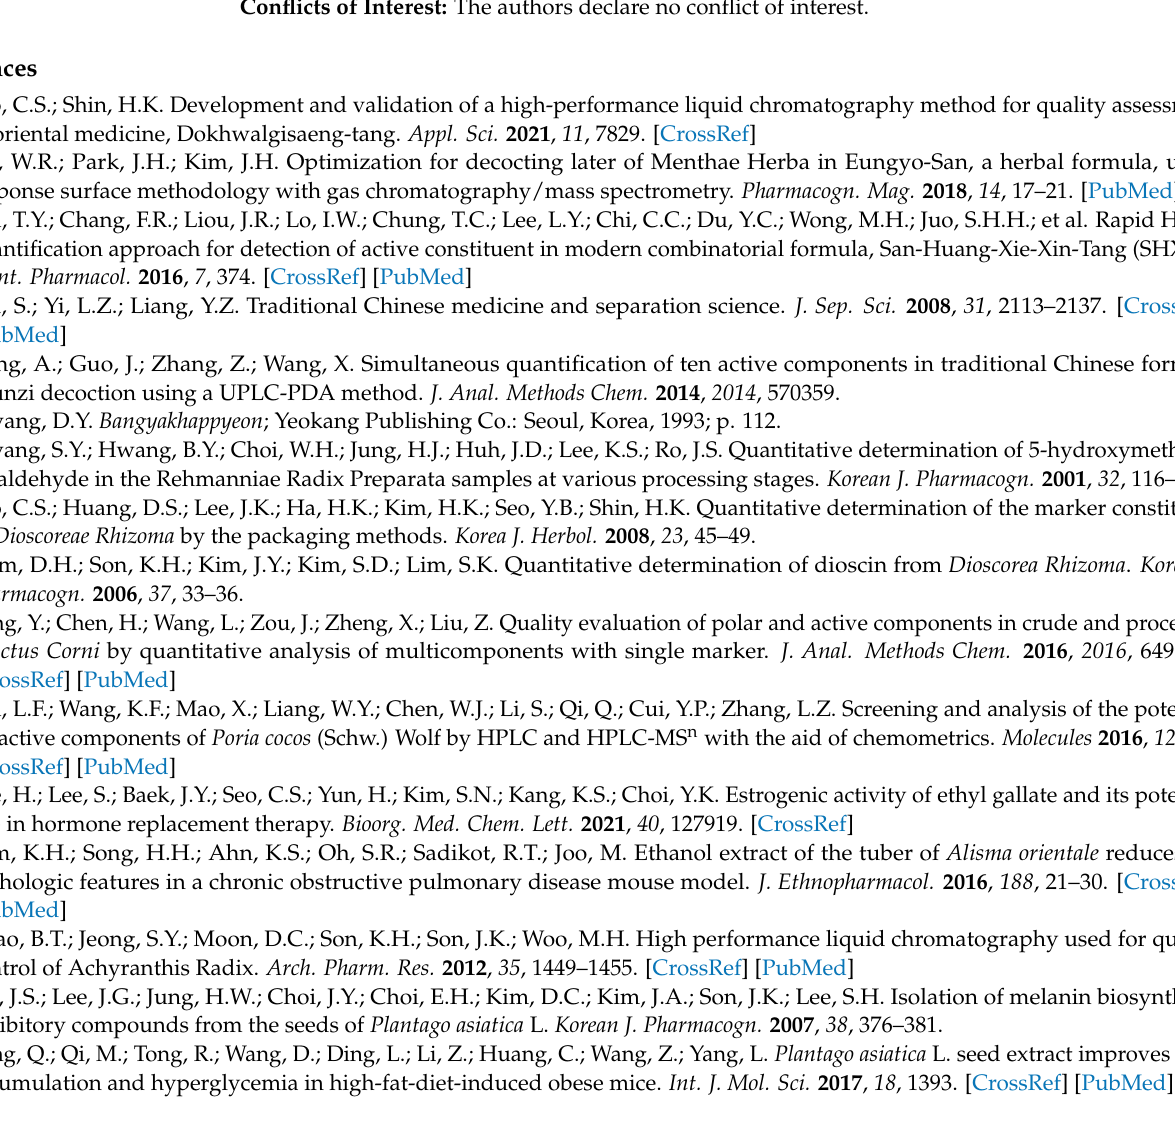
HPLC chromatographic conditions for analyzing the 11 analytes of GGSGH; Table S3: UPLC–MS/MS conditions for simultaneous analysis of the 11 analytes in GGSGH samples; Table S4: Parameter comparison of analytes according to different columns; Table S5: Effect of column oven temperatures on selected column; Table S6: Effect of acids on selected column and column oven temperature; Table S7: Repeatability for retention times and peak areas of compounds 1 – 11 ; Table S8: System suitability of compounds 1 – 11 ; Table S9: The retention time, linear range, regression equation, r 2 , and LOD of the analytes from GGSGH using LC–MS/MS MRM mode. Author Contributions: Conceptualization, C.-S.S. and M.-Y.L.; performing experiments and